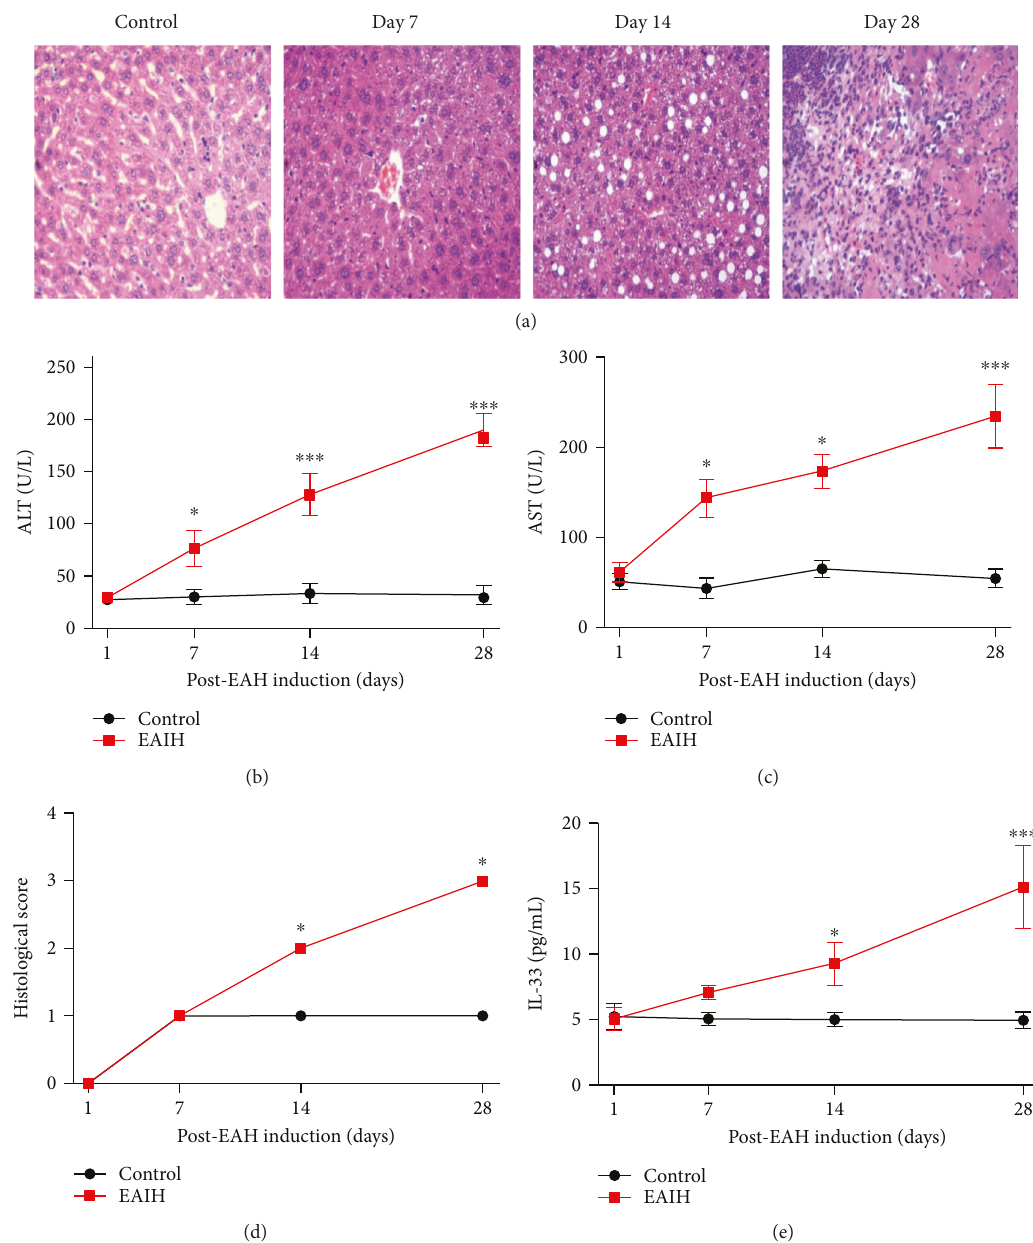
Figure 5: Serum levels of IL-33 in EAIH mice. Ten mice (5 from the EAIH group and 5 from the control group) were killed at each time point (7, 14, and 28 days). (a) Representative histological image of liver lesions in animals after standard induction of EAIH (magni fi cation, 100x). (b) Serum ALT levels were progressively upregulated from 1 to 28 days. (c) Serum AST levels were progressively upregulated from 1 to 28 days. (d) Histological score of liver lesions in mice after standard induction of EAIH. (e) Serum IL-33 levels were progressively upregulated from 1 to 28 days. Data shown are the mean levels of serum IL-33 in each mouse from two separate experiments. The horizontal lines indicate the mean values for the di ff erent groups. ∗ P < 0 05 ; ∗∗∗ P < 0 001